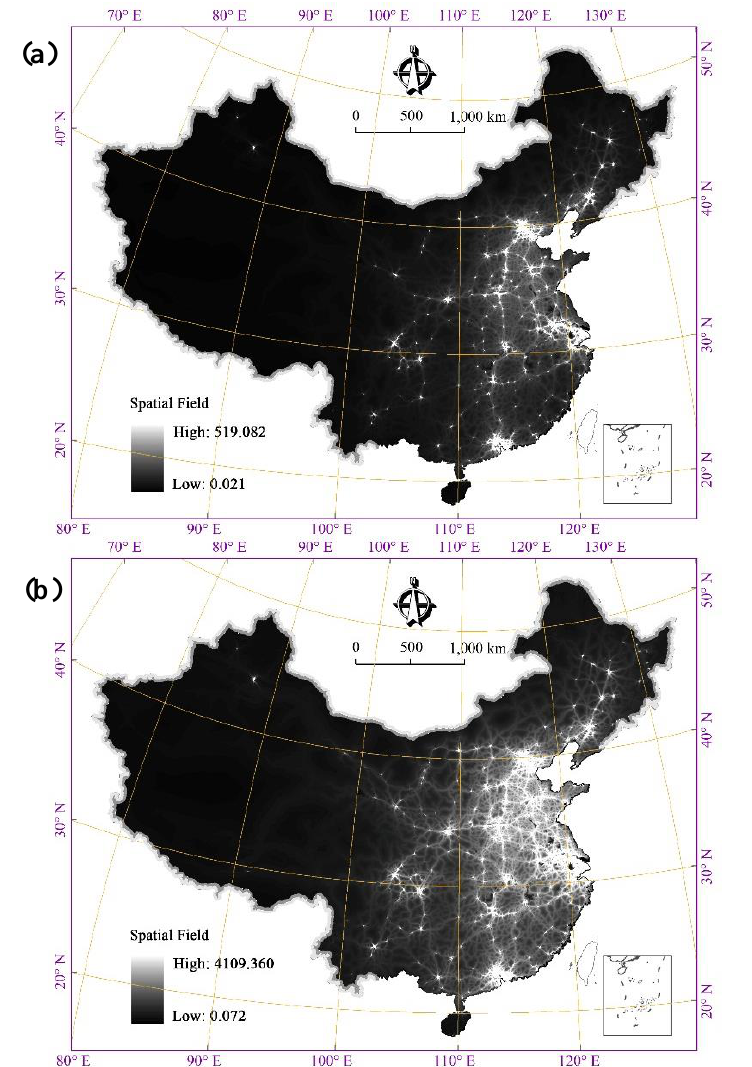
Figure 3. Distribution pattern of spatial field in China for the year of ( a ) 2000 and ( b )